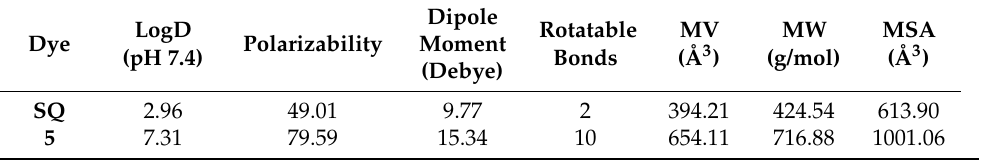
Table 1. Physicochemical properties of dye 5 calculated using ChemAxon.